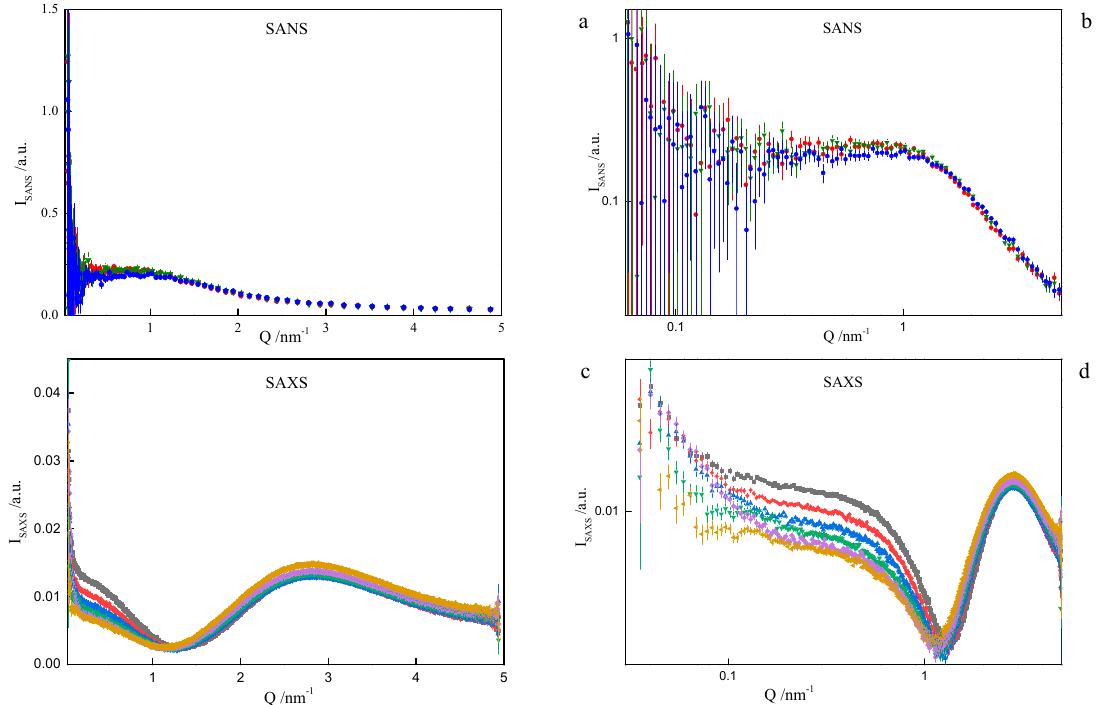
Figure 11. Observed Small-Angle Neutron Scattering (SANS) ( a ) and ( b ) and X-ray Scattering (SAXS) ( c ) and ( d ) spectra for the cationic dimeric 8-6-8 surfactant system for C s = 0.22 mol dm − 3 at: ■ —293.15 K, ● —298.15 K, ▲ —303.15 K, ▼ —308.15 K, ♦ —313.15 K, ◄ —318.15 K.